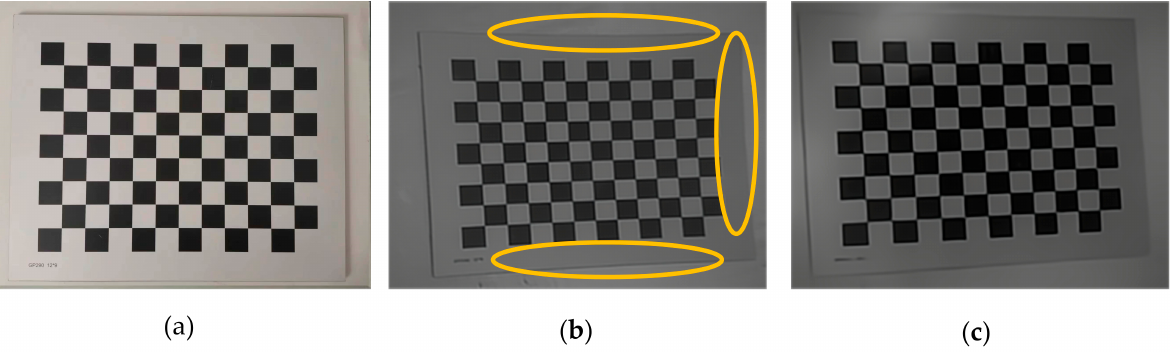
Figure 1. Calibration plate design and results in experimental use of calibration plates: ( a ) calibration late; ( b ) before the picture was corrected, the calibration plate was recessed inward in a curved shape all around; ( c ) after picture correction, the calibration plate is straight all around.